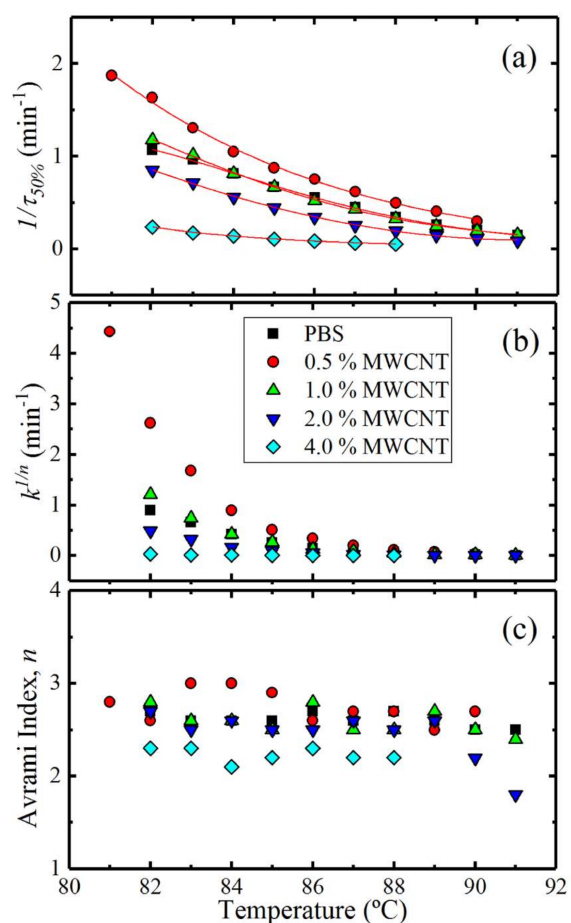
Figure 13. ( a ) Overall half-crystallization rate (the solid lines indicate the Lauritzen and Hoffman fitting); ( b ) Normalized crystallization constant of the Avrami model ( k 1/ n ); ( c ) Avrami index ( n ) as a function of the isothermal crystallization temperature ( T c ) for all the